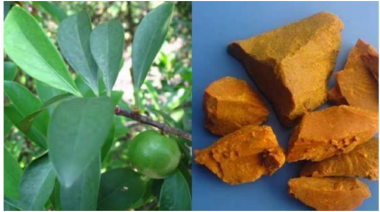
Figure 1. Garcinia plant and its dried